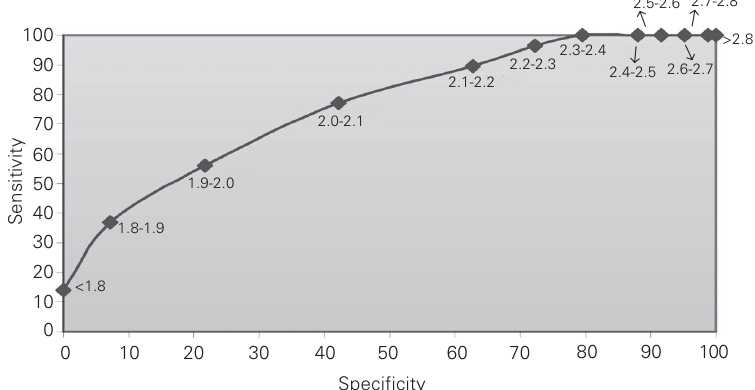
Figure 1. Receiver operator characteristic curve for the performance of the QT/RR ratio as a factor discriminating between a normal and a prolonged QTc (>0.423 s for males and >0.439 s for females).